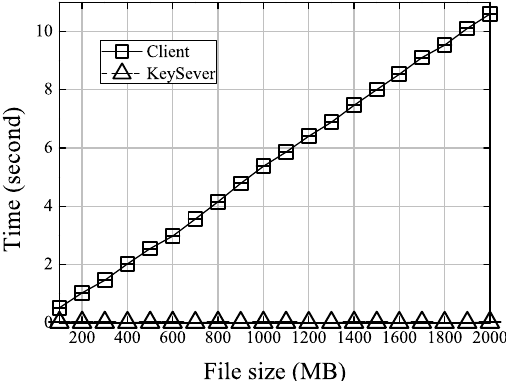
Figure 1. Computational cost for the PreUpload phase. Upload . The computational cost for Case 1 and Case 2 of the Upload phase (Section 4.3) are shown in Figures 2 and 3, respectively.